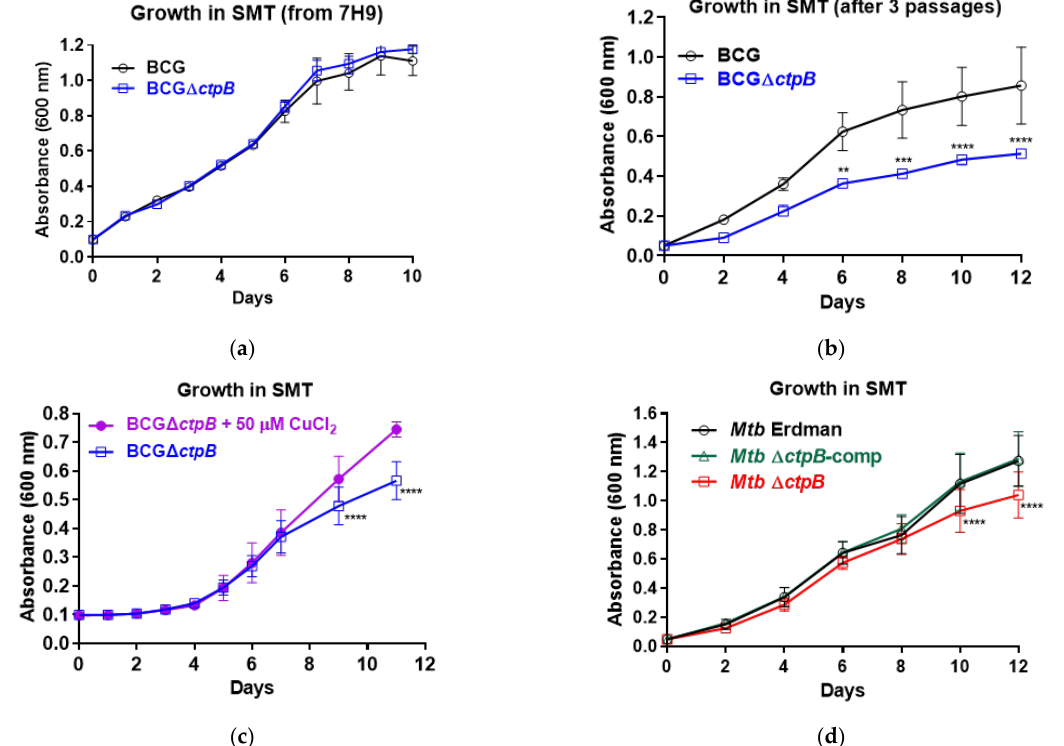
Figure 3. Growth of BCG and M. tuberculosis ctpB mutants is impacted by copper availability. ( a ) Growth of M. bovis BCG or ctpB - deletion mutant (BCGΔ ctpB ) after subculture from 7H9 to SMT ( a ) Growth of M. bovis BCG or ctpB -deletion mutant (BCG ∆ ctpB ) after subculture from 7H9 to SMT medium. ( b ) Growth of BCG and BCGΔ ctpB after three serial passages in SMT. ( c ) Growth of BCGΔ ctpB in SMT +/ − 50 μM CuCl 2 after three passages in SMT. ( d ) Growth of M. tuberculosis ctpB - medium. ( b ) Growth of BCG and BCG ∆ ctpB after three serial passages in SMT. ( c ) Growth of deletion mutant ( Mtb Δ ctpB ), parent strain ( Mtb Erdman), and complemented mutant ( Mtb Δ ctpB - BCG ∆ ctpB in SMT +/ − 50 µ M CuCl 2 after three passages in SMT. ( d ) Growth of M. tuberculosis ctpB -deletion mutant ( Mtb ∆ ctpB ), parent strain ( Mtb Erdman), and complemented mutant ( Mtb ∆ ctpB